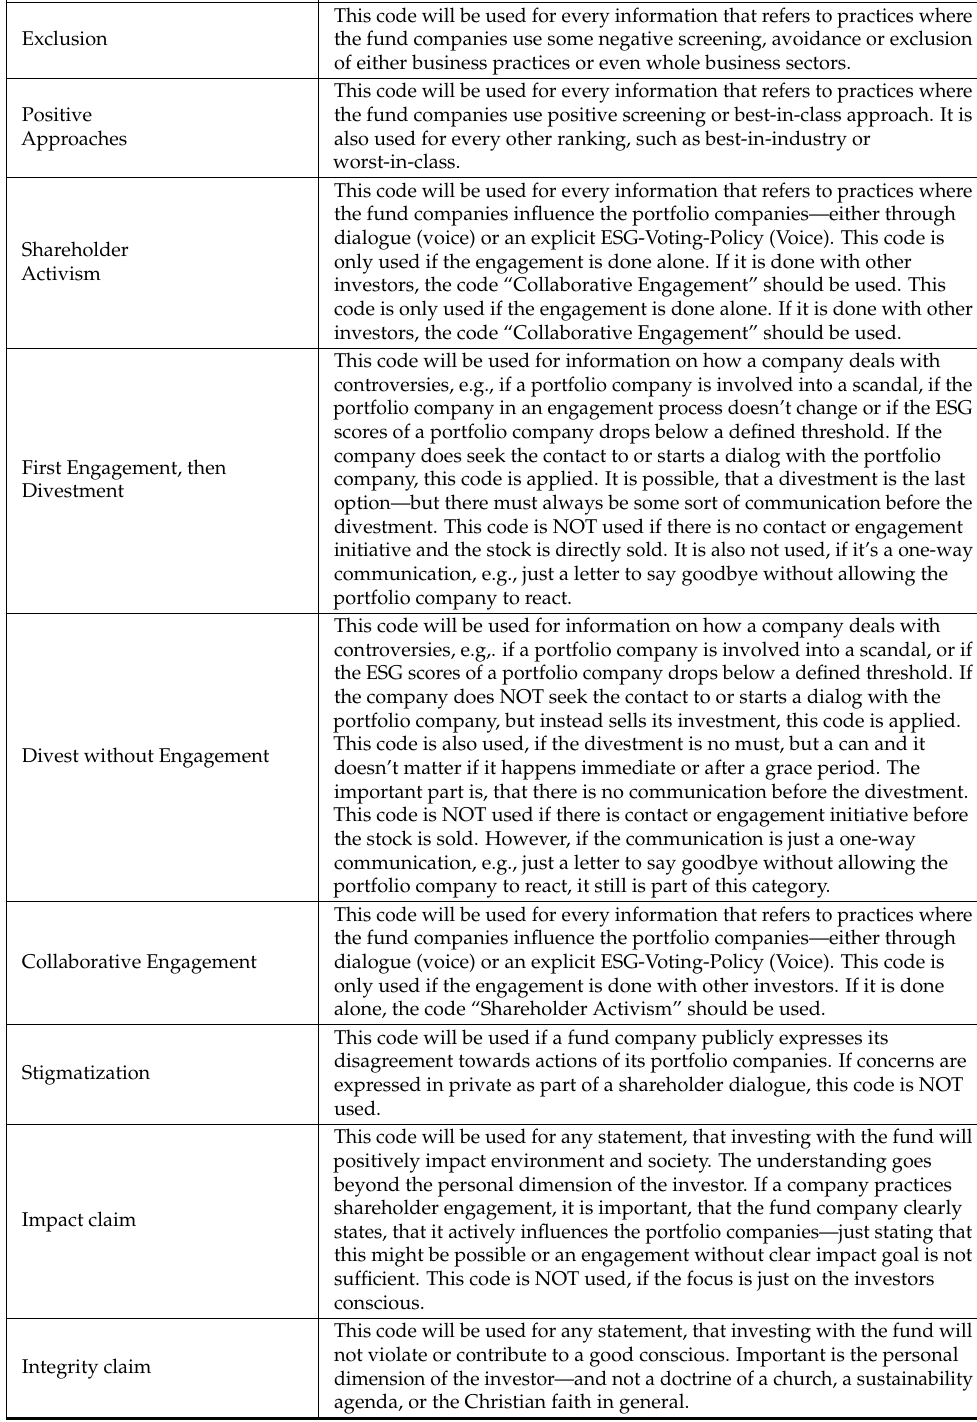
Table A3. Definition of Investment